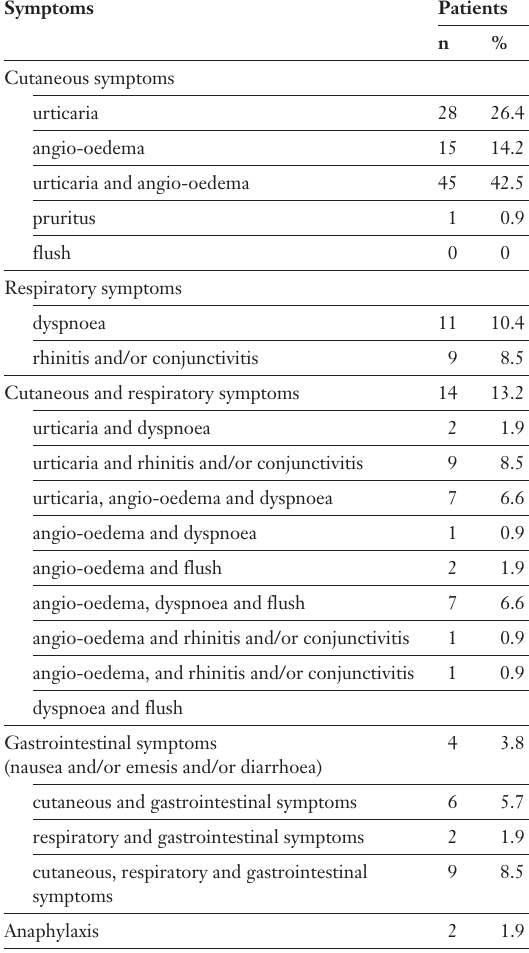
Symptomes reported by 106 patients after NSAID